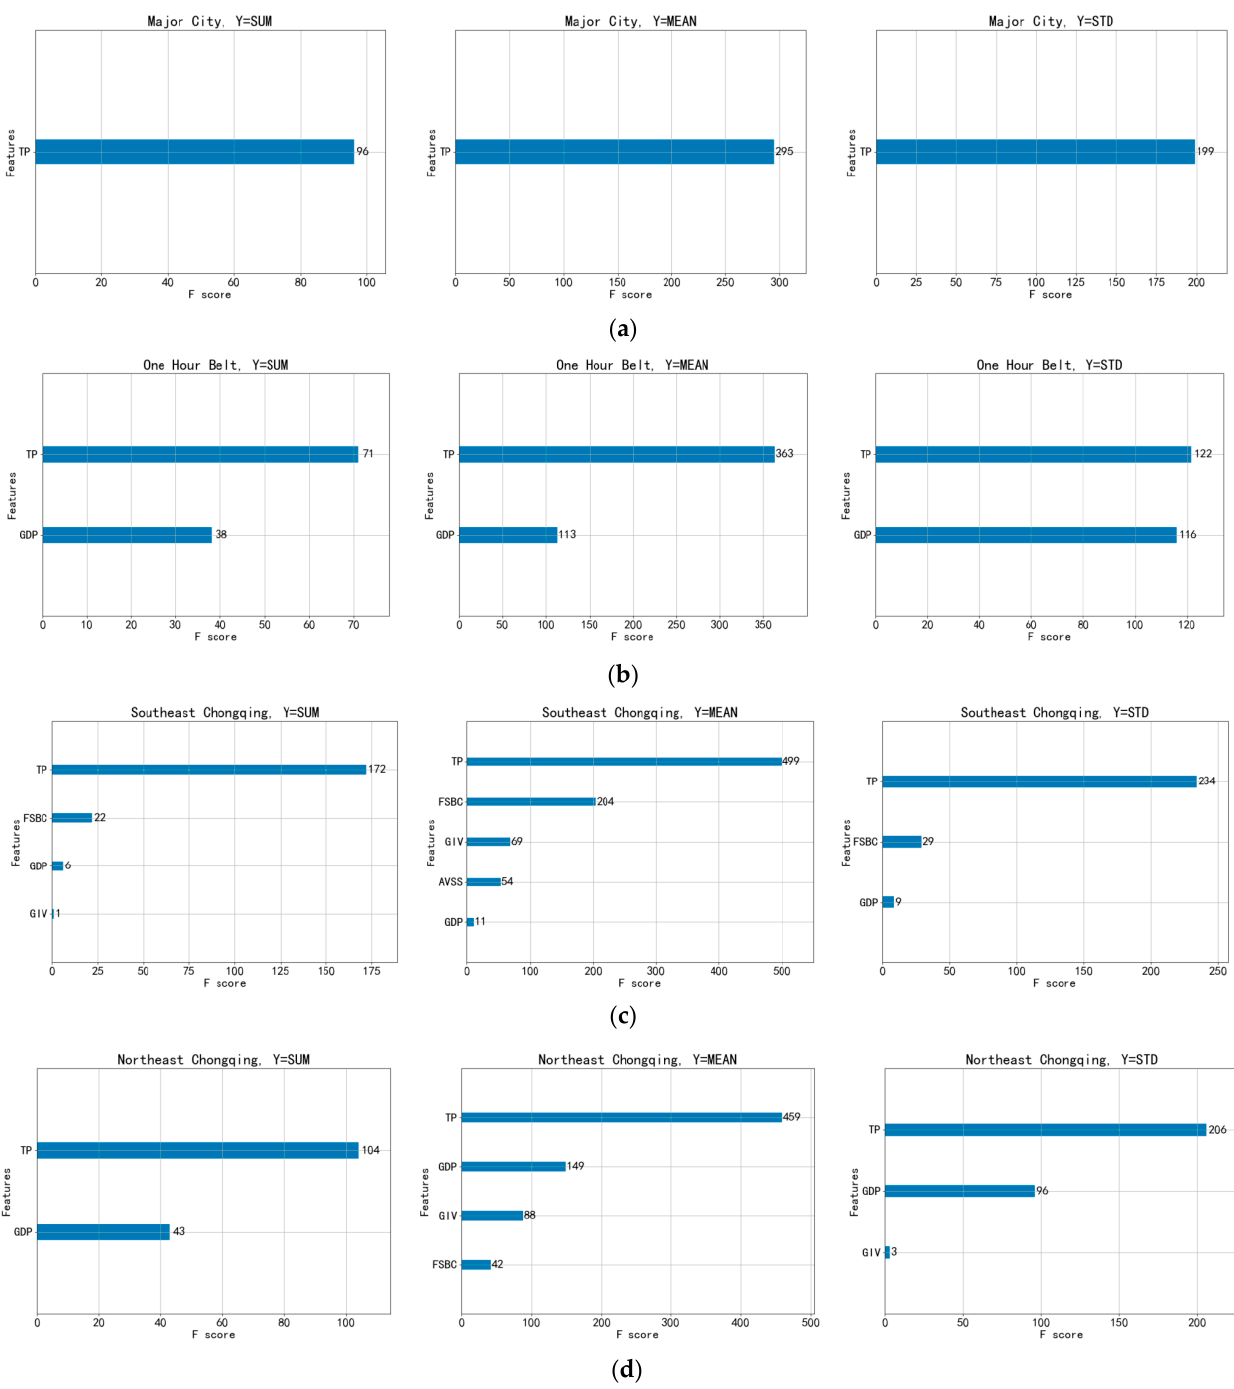
Figure 9. Results of Decision Tree Regression at the sub-city scale. ( a ) The metropolitan area; ( b ) The one-hour belt zone; ( c ) Northeast Chongqing; ( d ) Southeast Chongqing.